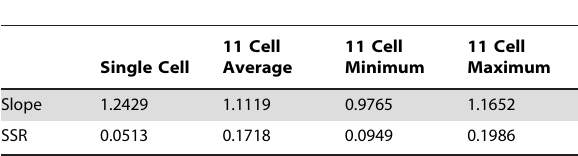
Table 3. Linear regression slopes and sum of squared residuals of single and 11 cell cases for change in cellular aspect ratio vs macro-scale effective strain.